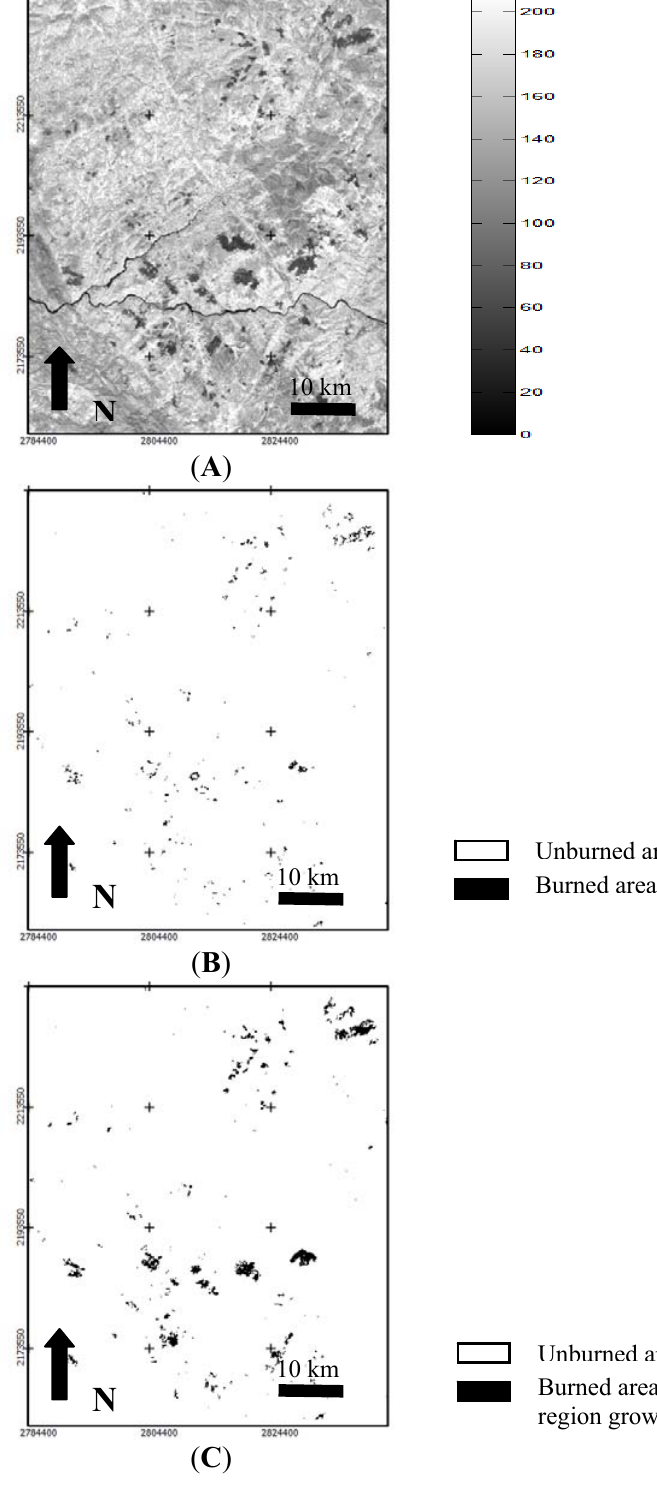
Figure 3. Burned scar mapping approach sequence for an area in northern Portugal ((ETRS89/LAEA projection). ( A ) AWIFS near infrared band; ( B ) Burned area seeds; ( C ) burned area after region growing. Unburned areas as represented in white